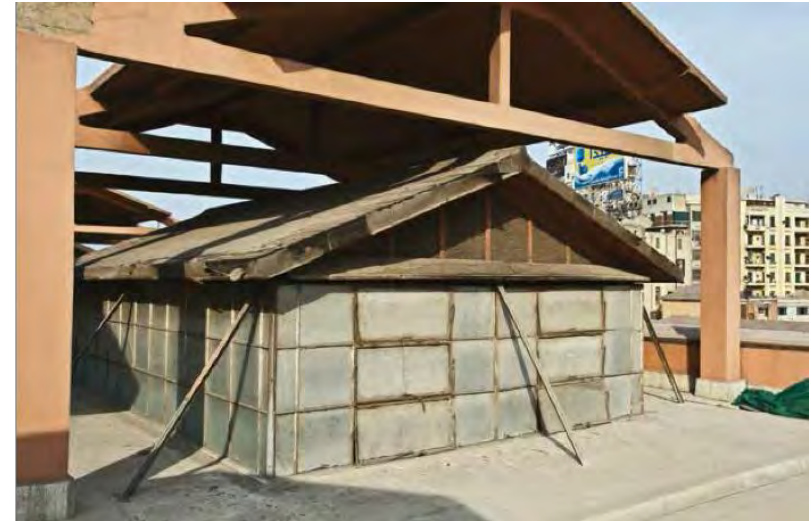
Figure 5. Roof modifications after 1967 war to protect it from air strikes (Photo by EQI report for reviving of the Egyptian museum in